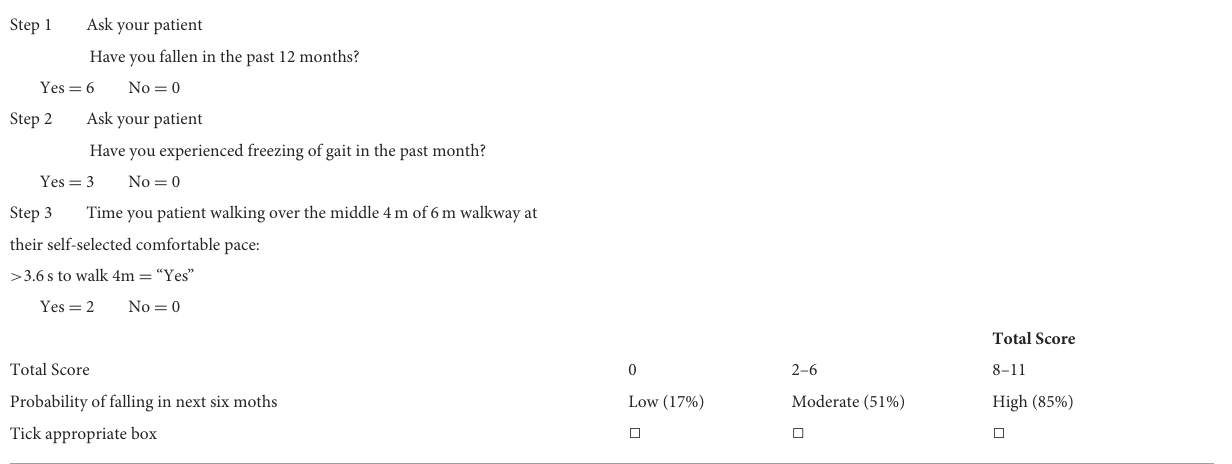
TABLE 2 3-Step-fall-prediction. Assessing the probability of falling in People with Parkinson’s